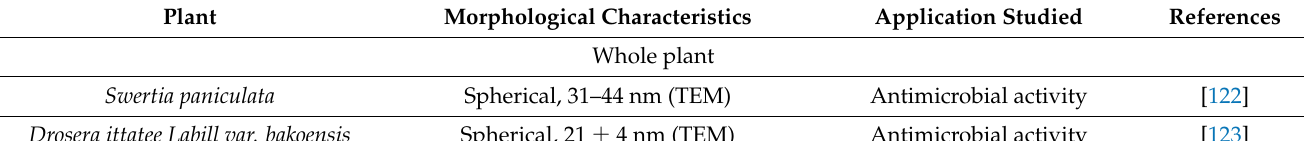
Table 6. Plant-mediated synthesis of AgNPs, their morphological characteristics, and their